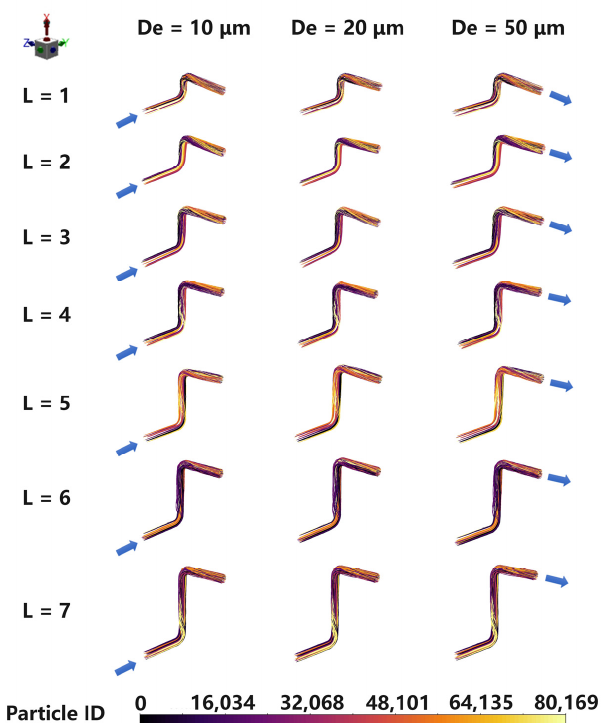
Figure 8. Particle trajectory diagram with average particle diameters and the length of Straight-2. Particle trajectories subject to the Rosin–Rammler particle size distribution function are tracked, as shown in Figure 8, which shows 80,169 incoming particles of the particle flow, numbered and distinguished by different colors. It is divided into three columns, according to the average particle size. Particle trajectories vary from the length of Straight- 2. The reason for the difference seems to be that the gas–solid two-phase flow passing through Straight-2 needs to overcome gravity and friction, so the particle energy decreases gradually. In addition, the centrifugal force through the elbows also affects the particle trajectory. Particle trajectories using the DPM are compared with those calculated by the DDPM, as shown in Figure 9. The interactions between particles in the DPM are ignored, so there are deviations from particle trajectories calculated by the model used in this pa- per.